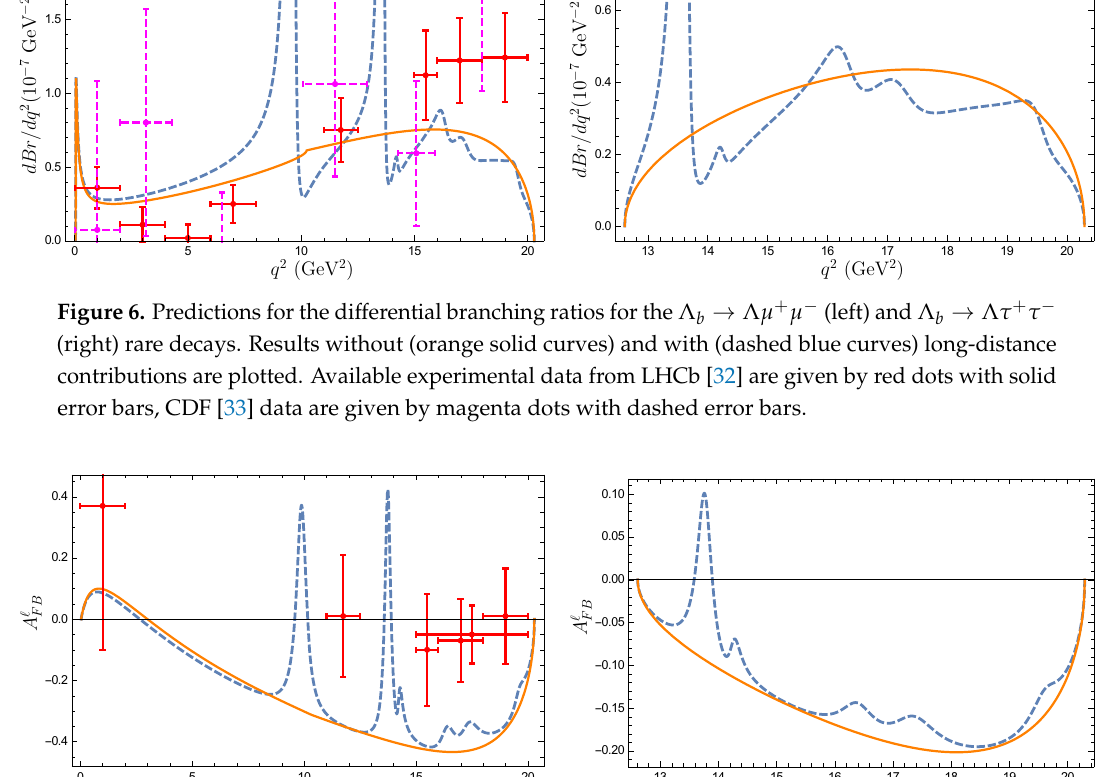
Figure 7. Predictions for the lepton forward-backward asymmetries A (cid:96) Λ τ + τ ( left ) and Λ b − ( right ) rare decays. Notations are the same as in Figure →